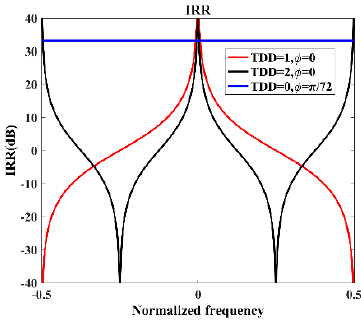
Figure 2. IRR curves with TDD and LO phase offset.